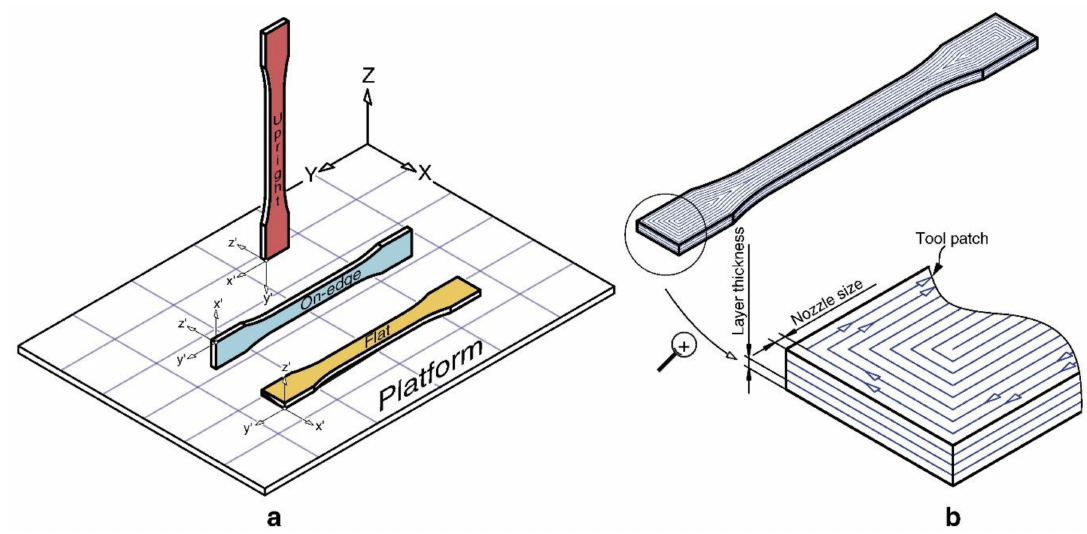
Figure 2. ( a ) Flat, on-edge, and up right printing orientation of tensile bars. ( b ) Processing parameters of tensile bars. Reproduced with permission from [27], Elseveir,